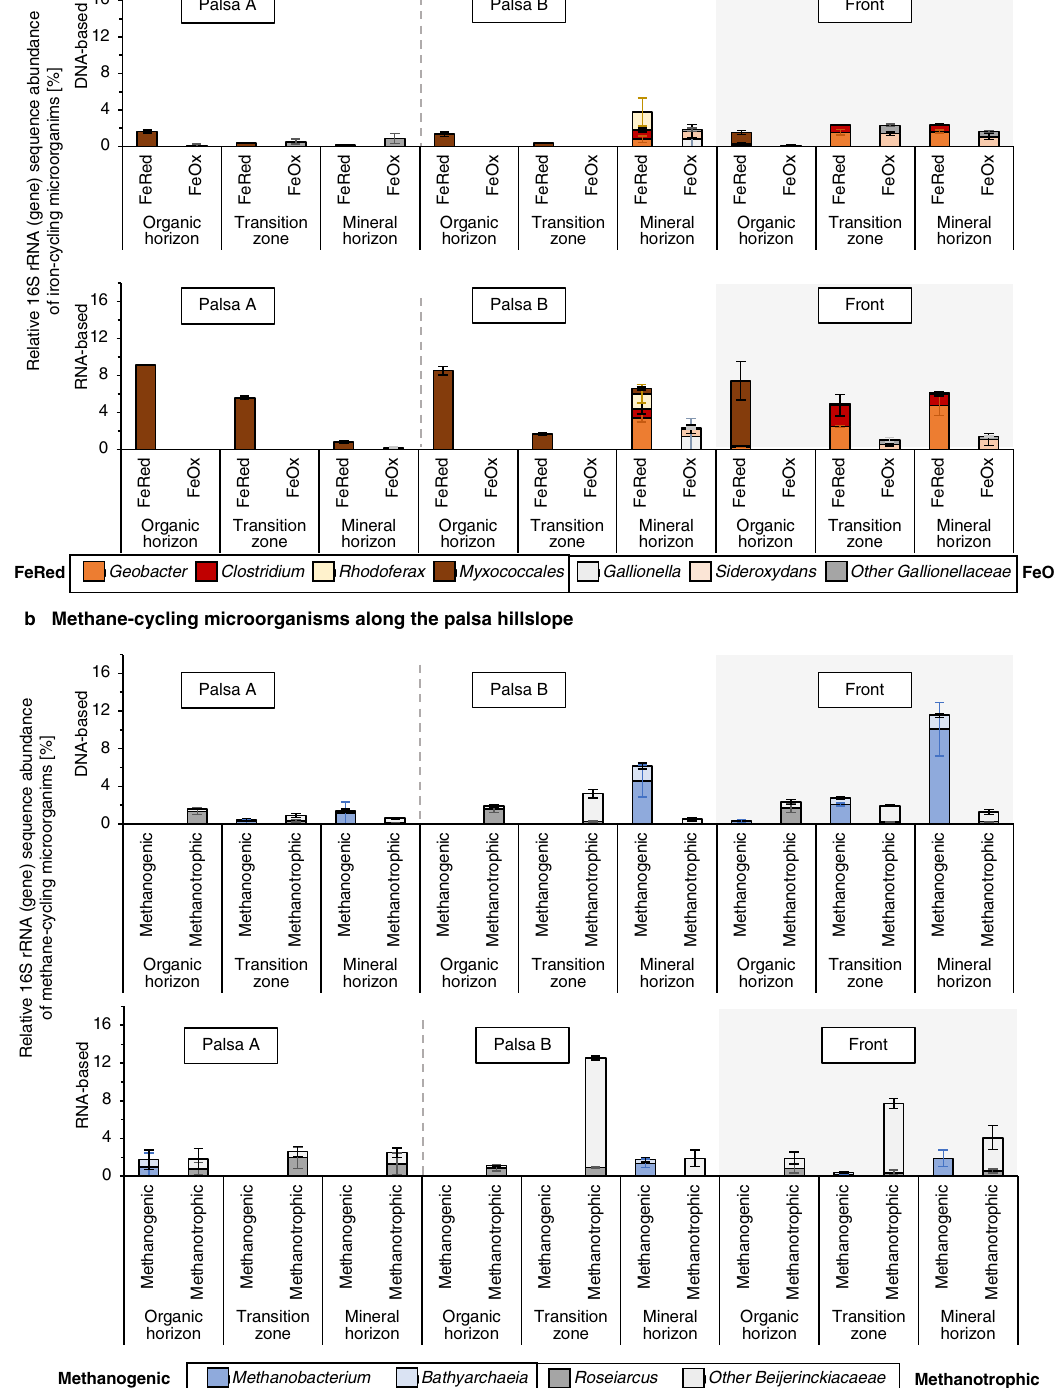
Fig. 2 Relative 16S rRNA (gene) abundance of abundant (DNA-based) and likely active (RNA-based) iron- and methane-cycling microbial communities along the palsa hillslope (Palsa A, Palsa B, Front). a Iron-cycling microorganisms show an increasing relative 16S rRNA (gene) abundance (DNA- and RNA-based) along the palsa hillslope with highest abundances in the transition zone and mineral horizon at the collapsing front. b Methane- cycling microorganisms are increasing in relative 16S rRNA (gene) abundance along the palsa hillslope. Reported values and error bars represent the average and standard deviation of triplicate analysis of each soil horizon along the palsa hillslope. Replicate cores show similar relative 16S rRNA (gene) abundance of abundant (DNA-based) and potentially active (RNA-based) iron- and methane-cycling microbial communities along the palsa hillslope (Supplementary Fig. S11, Supplementary Tables S1 –